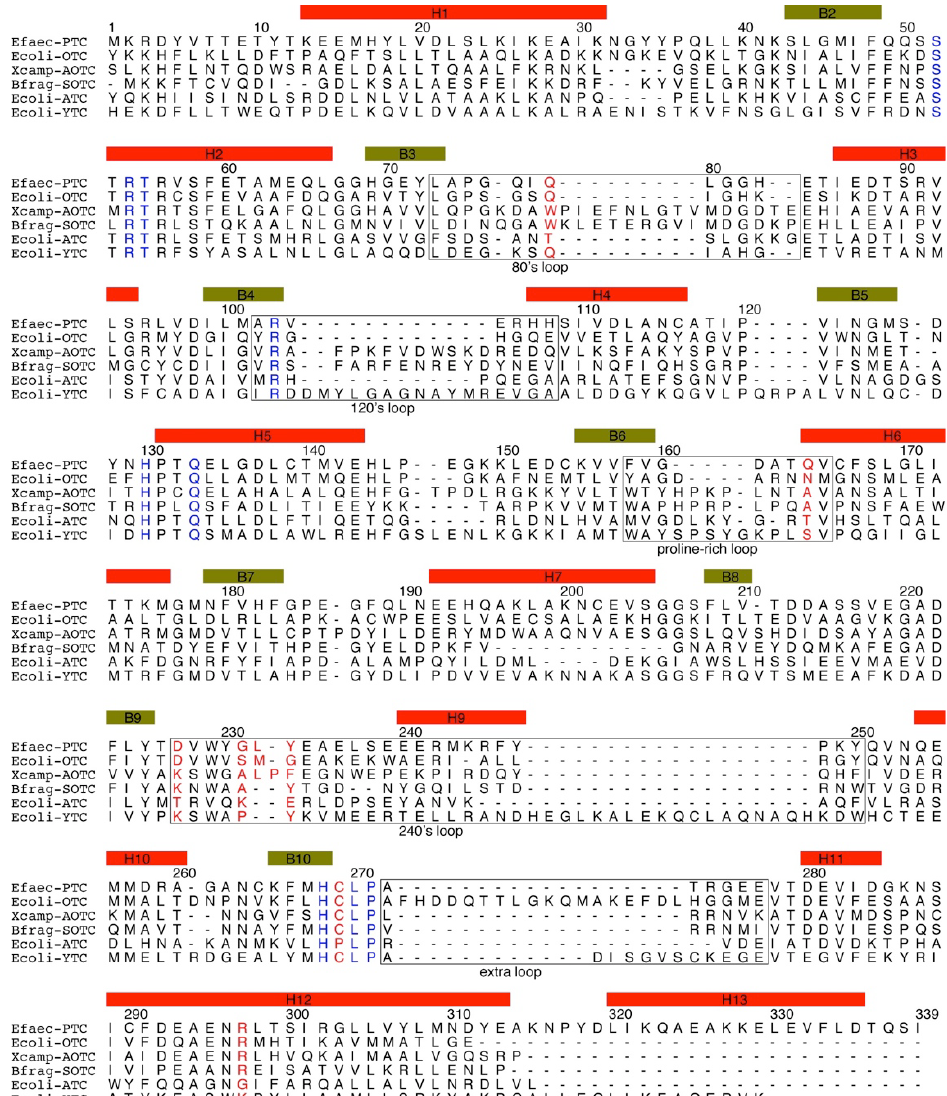
Figure 2. Sequence alignment of Enterococus faecalis PTCase, Escherichia coli OTCase, Xanthomonas campestris AOTCase, Bacteroides fragilis SOTCase, E. coli ATCase and E. coli YTCase. Sequence encoding secondary structure elements (based on the E. faecalis PTCase structure) are indicated by boxes in yellow-green (β-strand) and red (α-helix). The conserved motifs, SxRT, HPxQ and HxLP across transcarbamylase members are indicated in blue. Nonconserved residues, which might be involved in binding substrates, are indicated in red. The 80’s, 120’s, proline-rich, 240’s and extra loops are